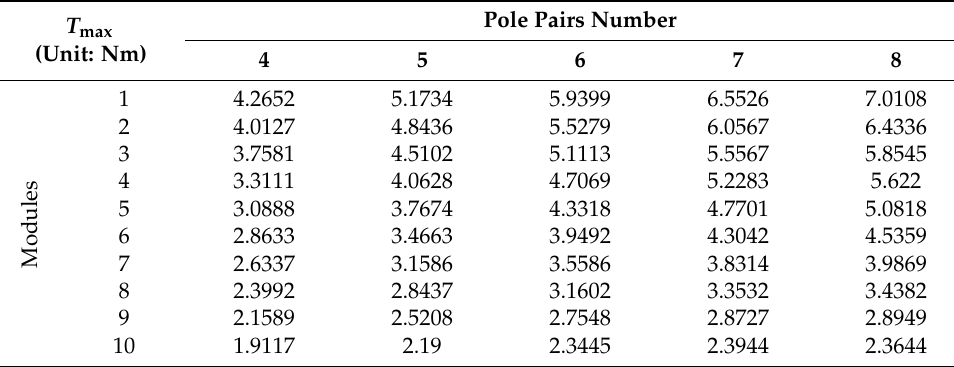
Table 6. T max of each module with different pole pairs.